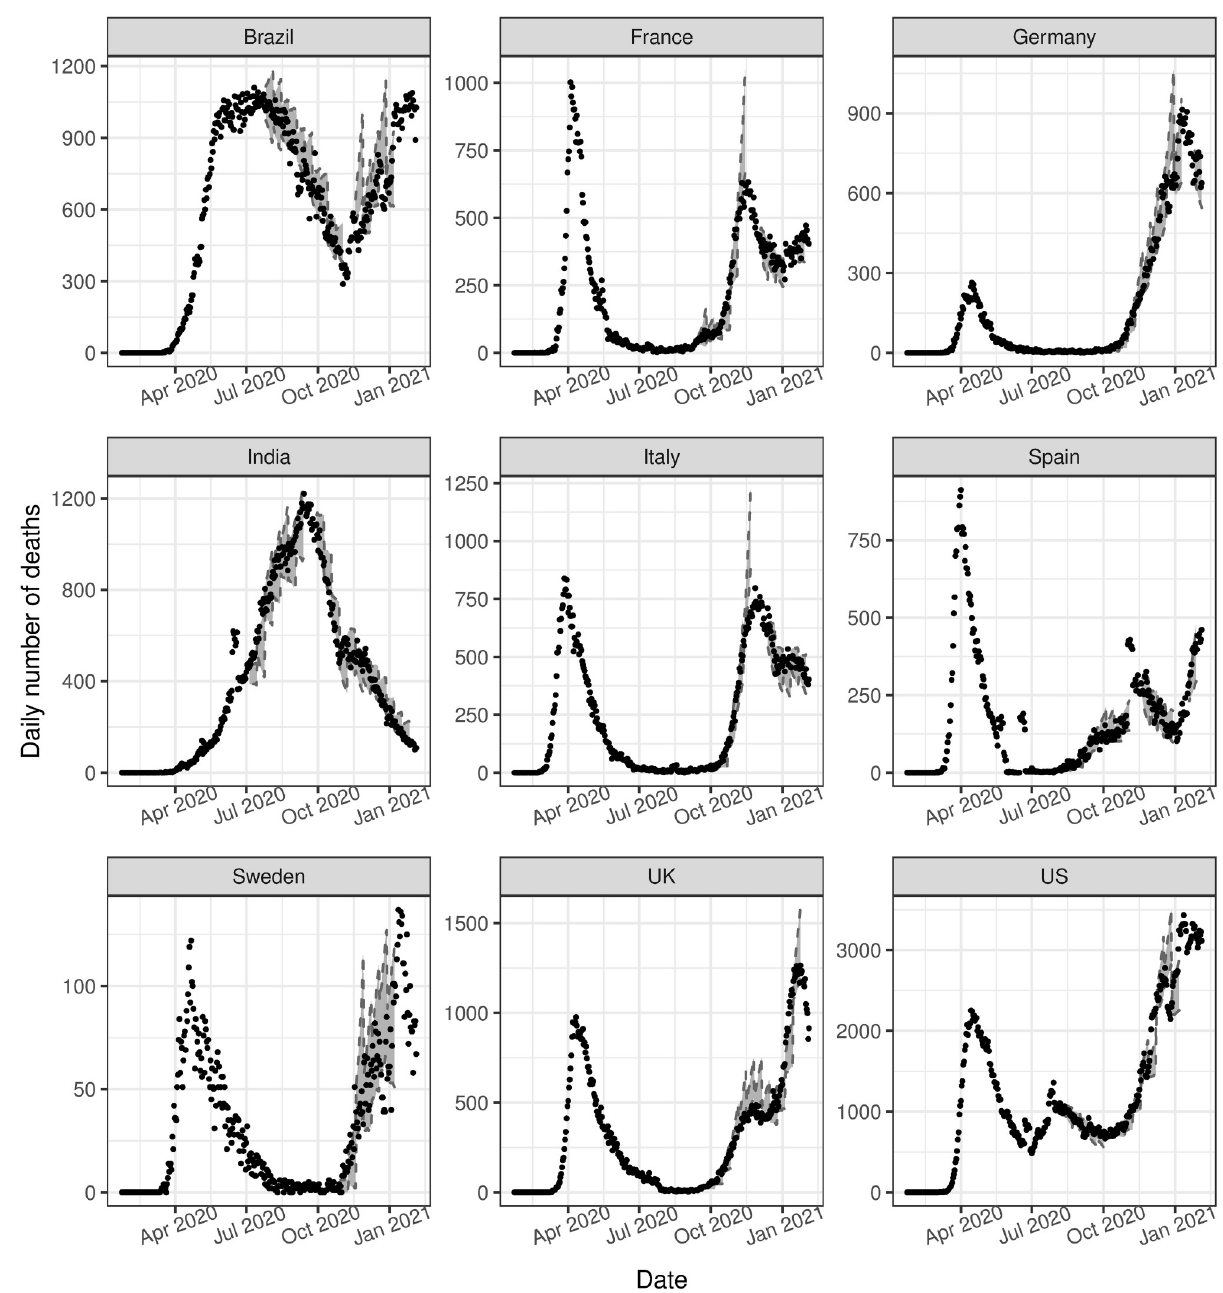
Fig 8. Out-of-sample validation (subsequent analysis). The observed number of deaths (black dots) compared to the 95% posterior predictive interval for the estimated expected number of events, i.e. λ ( t ) using various training datasets (grey ribbons) for the subsequent analysis.